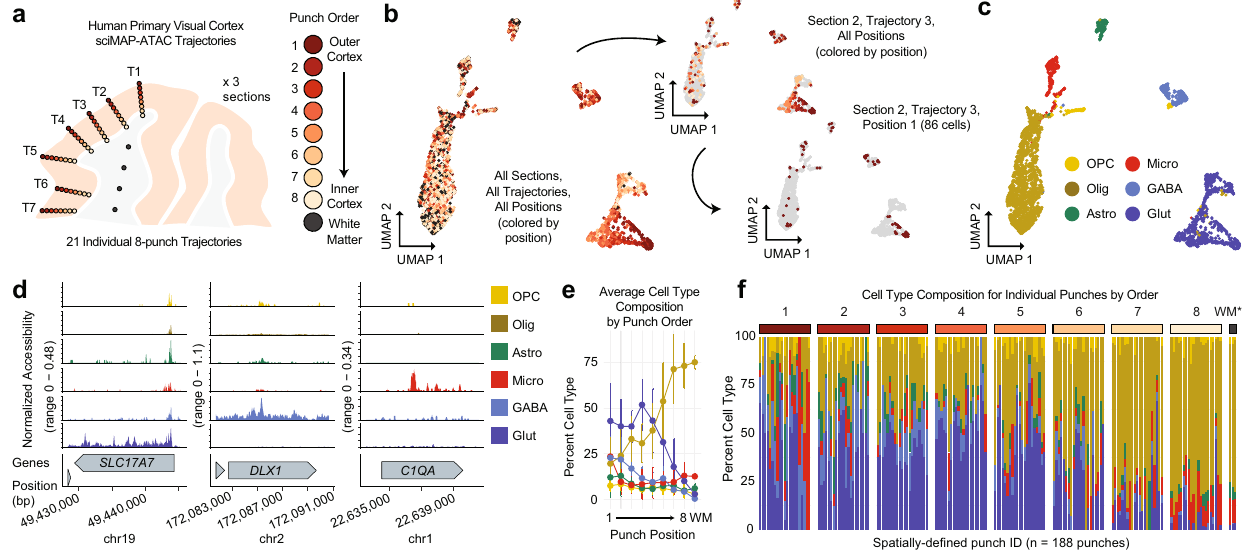
Fig. 4 sciMAP-ATAC trajectories through the human primary visual cortex. a sciMAP-ATAC punching schematic showing one of three adjacent sections from one individual. A total of 21 eight-punch trajectories (T) spanning the cortex were produced. b UMAP of cells colored by position within their respective trajectory as in a . Top right shows the same UMAP with all cells grayed out with the exception of cells from the third trajectory from section 2. Bottom right shows all cells grayed out with the exception of cells from a single punch; the outermost cortical position (1) from the third trajectory of the second section. c UMAP as in b colored by cell type (OPC oligodendrocyte precursor cells, Olig oligodendrocytes, Astro astrocytes, Micro microglia, GABA GABAergic (inhibitory) neurons, Glut glutamatergic (excitatory) neurons). d ATAC-seq pro fi les for cells aggregated by cell type for marker genes; colored by cell type as in c . e Aggregate cell type composition across the 21 trajectories ( n = 4547 cells over 188 independent punches); colored by cell type as in d . Data are presented as mean values ± SD. f Cell type composition for each of the 188 individual punches split by trajectory position. Punches from the WM indicated by an asterisk are aggregated by section. Colored by cell type as in d . Source data are provided as a Source data fi